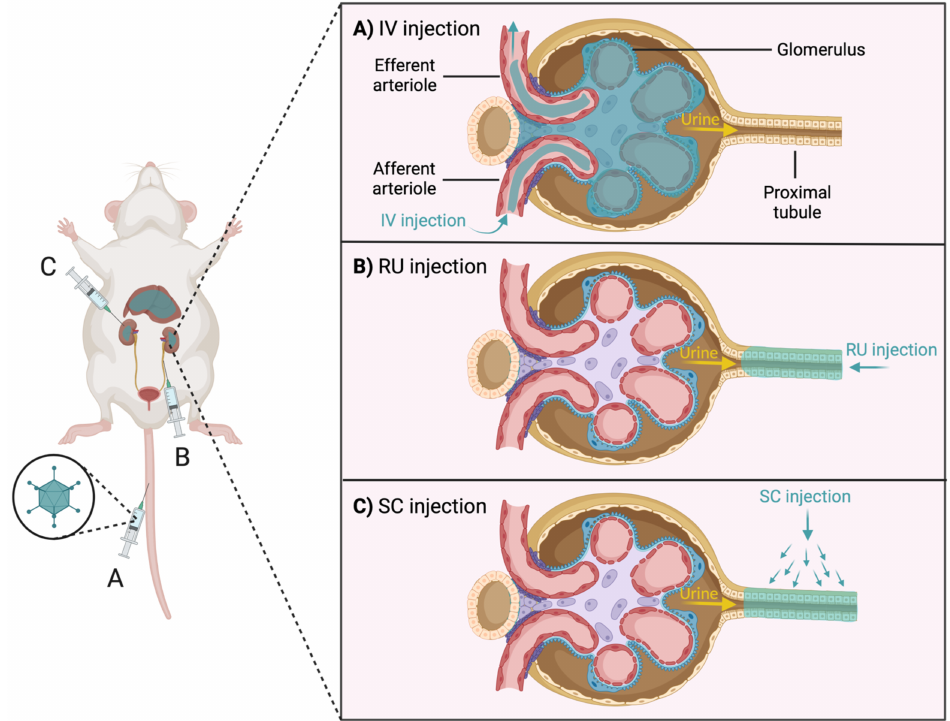
Figure 5. Expected target for infection in the context of the organism and the renal corpuscle after intravenous and direct kidney injection of typical viral vectors. Injection of viral vectors by any of the three strategies would infect renal cells, but mainly hepatocytes (left); ( A ) intravenous (IV) injection of viral vectors would cause only glomerular cells to be infected or recirculate into the bloodstream, due to the strict filtering functions of the glomerulus; ( B ) retrograde ureteral (RU) injection of viral vectors would avoid the filtering effects of the glomerulus but would be faced with going upstream against the natural flow of urine, although it would theoretically allow the vectors access to the tubules; ( C ) subcapsular (SC) injection of viral vectors would bypass the glomerulus and urinary flow and allow the vectors access to the tubules. Transduction is depicted with tissues and cells shaded in blue. Adenoviral vector